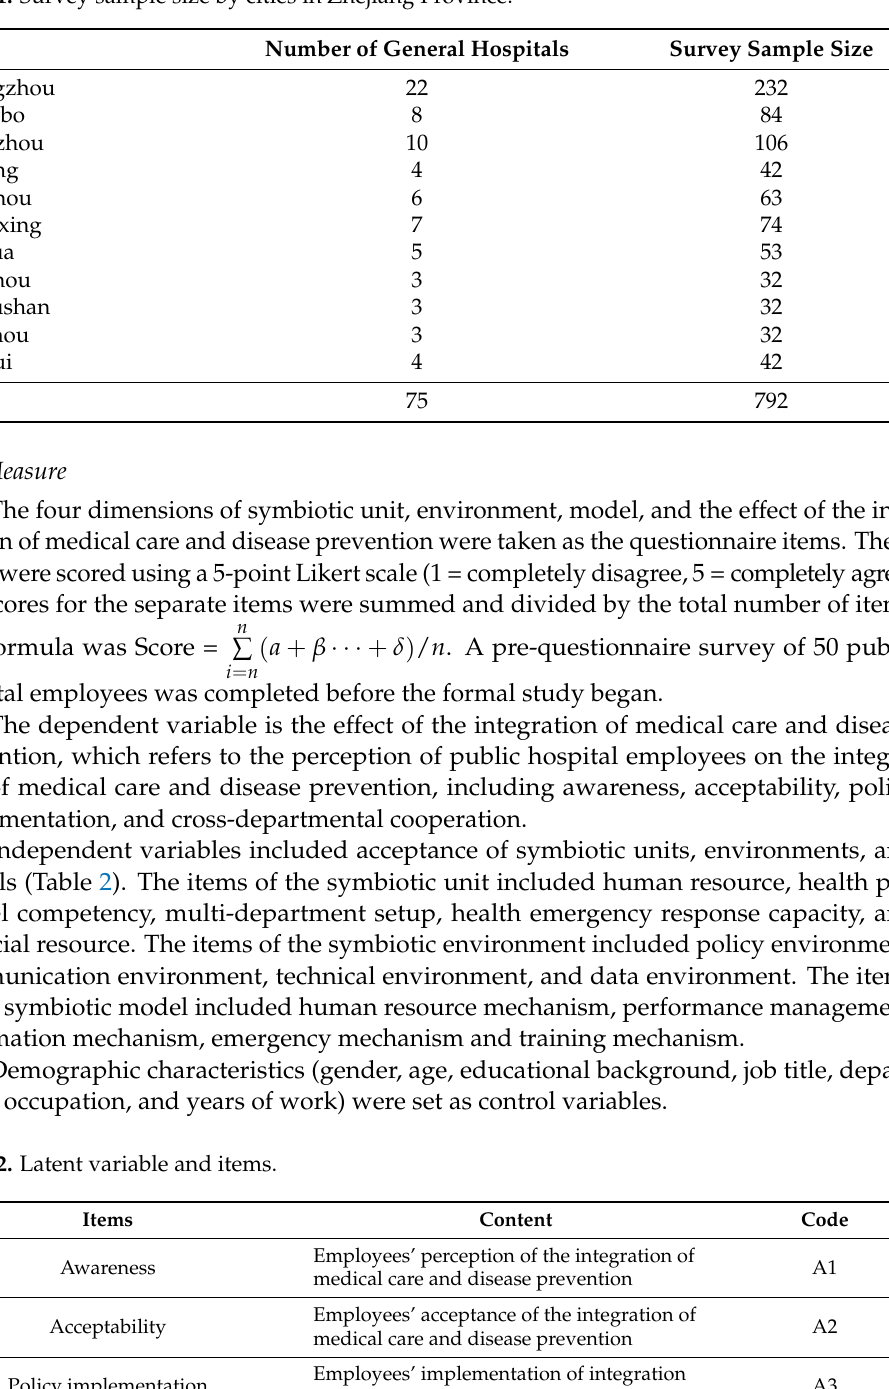
Table 1. Survey sample size by cities in Zhejiang Province.